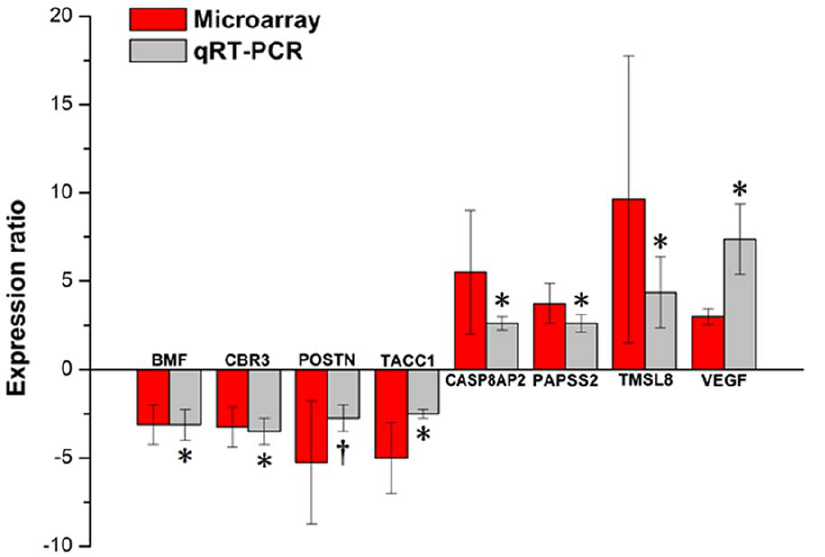
Figure 1. Histogram showing the expression values of the selected 8 genes measured by microarray and qRT-PCR. * indicates p , 0.05 and { indicates p , 0.01, calculated by paired t test.